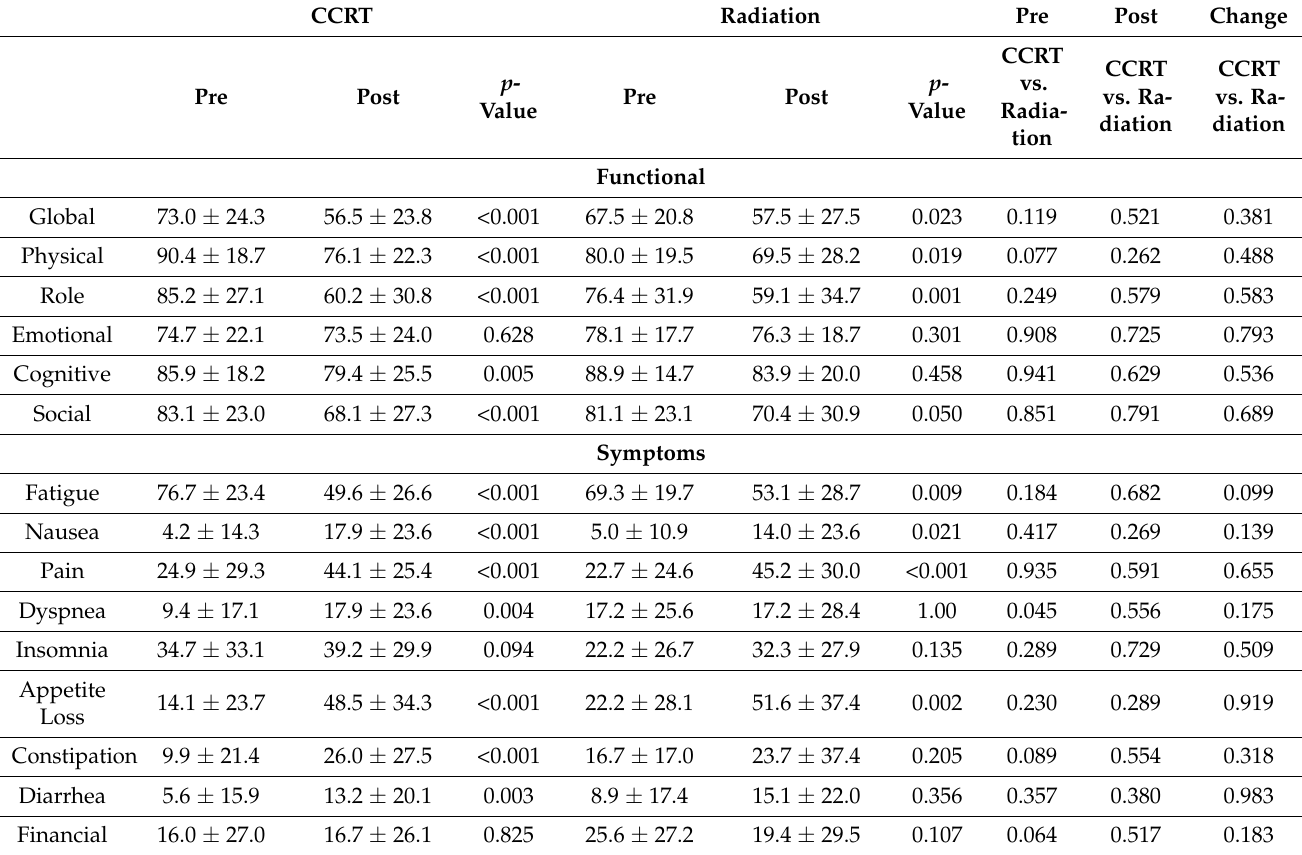
Table 2. Quality of